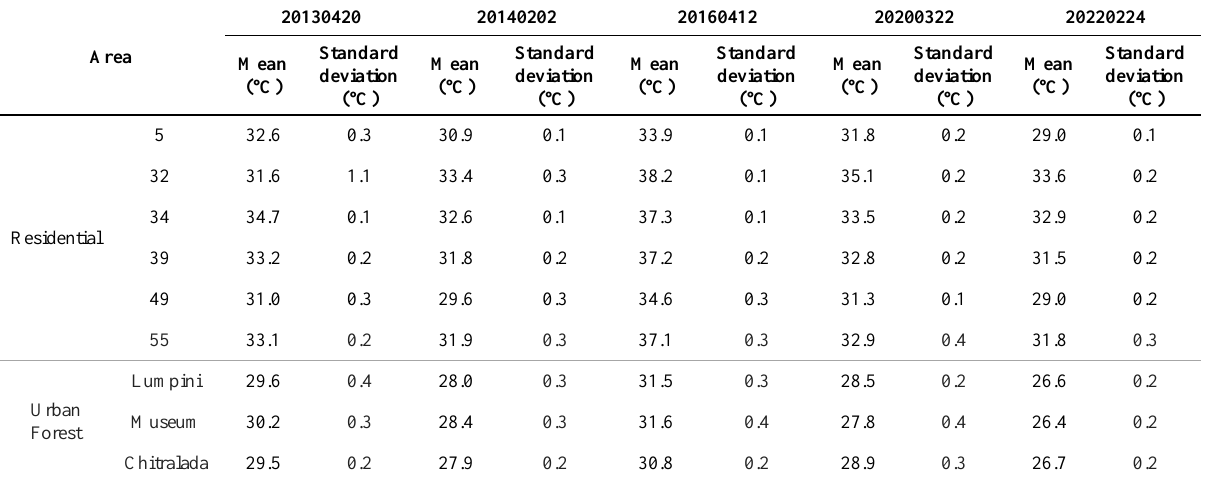
Table 3. Land surface temperature between the 2013 and 2022 Landsat 8 data acquisition times for selected 2005 to 2012– completed residential areas and urban forests as the references